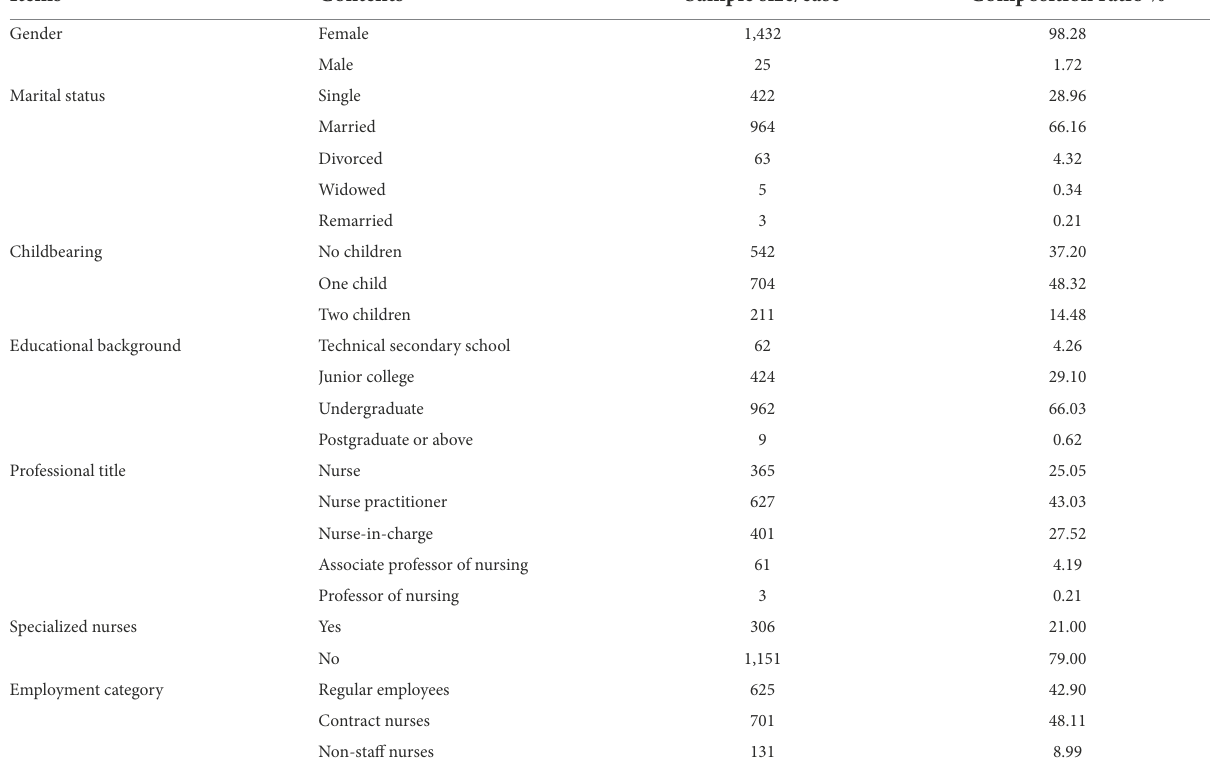
TABLE 1 General information about the survey participants ( n =